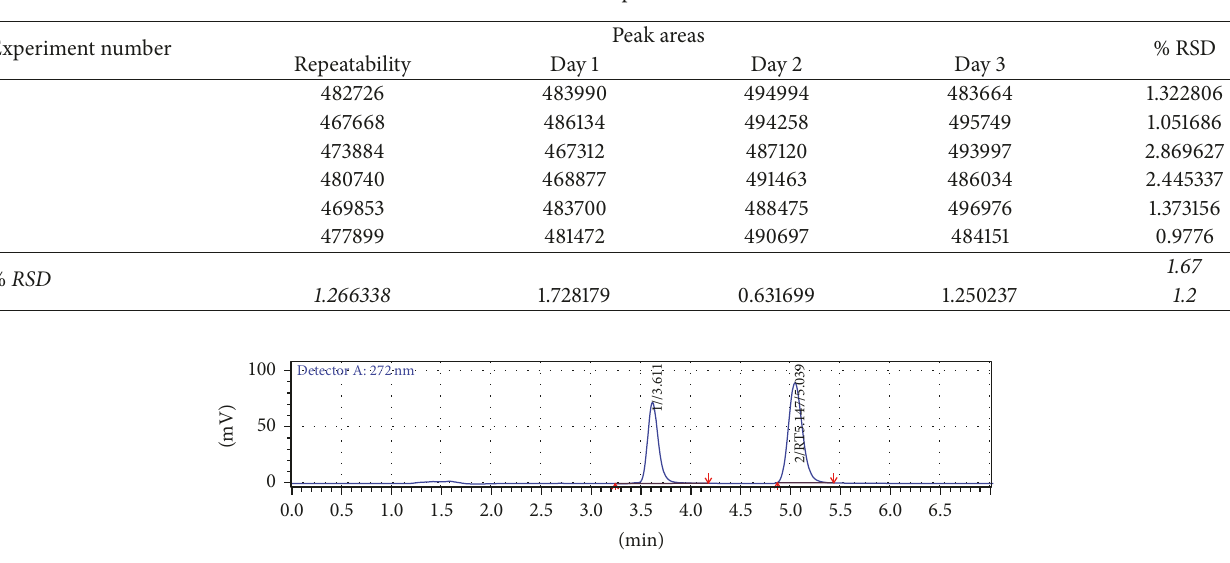
Figure 6: A chromatogram indicating the resolution between pro-NP and NP.